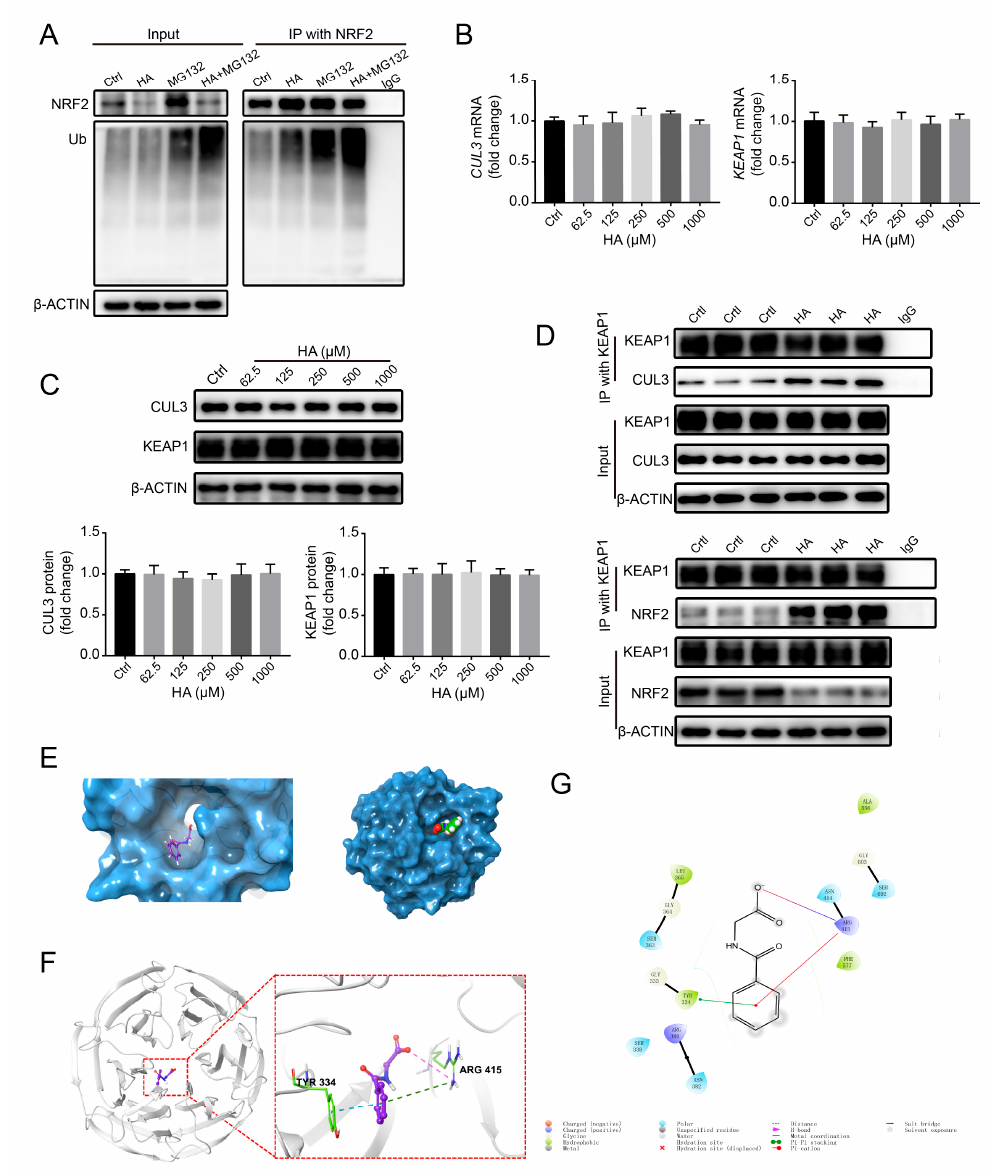
Figure 6. Effects of HA on NRF2 ubiquitination and E3 ubiquitin ligase in HK-2 cells. ( A ) Levels of NRF2 ubiquitination in cells pretreated with 10 µM MG132 (a proteasome inhibitor) or the vehicle, followed by treatment with 1000 µM HA. ( B ) Relative mRNA and ( C ) protein expression levels of Cullin 3 (CUL3) and Kelch-like ECH-associated protein 1 (KEAP1) after treatment with 0–1000 µM HA. Quantification was performed by densitometry. ( D ) Coimmunoprecipitation analysis of interactions between KEAP1 and CUL3 or NRF2 in cells treated with 1000 µM HA or the vehicle. ( E ) Surface representation of KEAP1 with a bound HA molecule (shown in a ball and stick format). ( F ) HA-binding site of KEAP1, shown with surface rendering. HA is depicted in a ball and stick format. ( G ) 2D detailed schematic of interactions between HA and KEAP1. Quantitative data are presented as the mean ± standard deviation. Experiments were repeated three to four times.